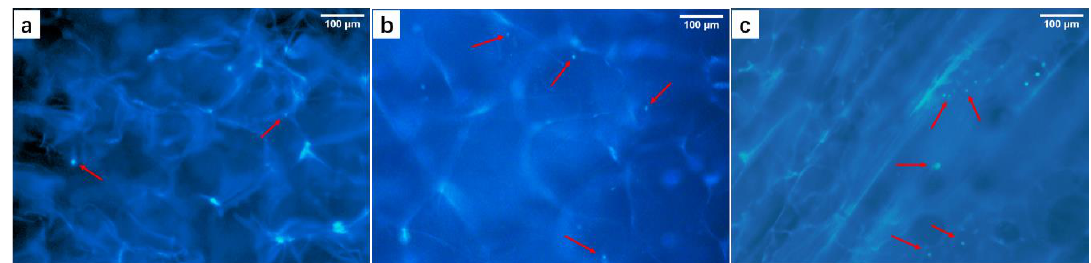
Figure 5. Adhesion of DPCs to the scaffolds. Three days after the DPCs were grown on the scaffolds, the nuclei were stained with DAPI (blue). The arrows point to the cells. ( a ) FCC, ( b ) AC, ( c ) FA. Scale bars = 100 μm.